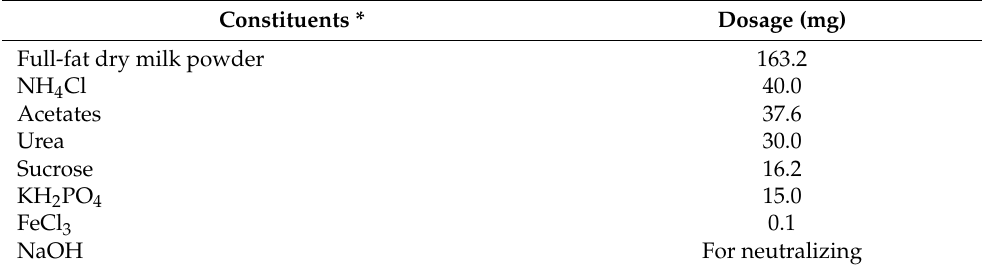
Table 1. The compositions of highly concentrated synthetic sewage (HCSS).